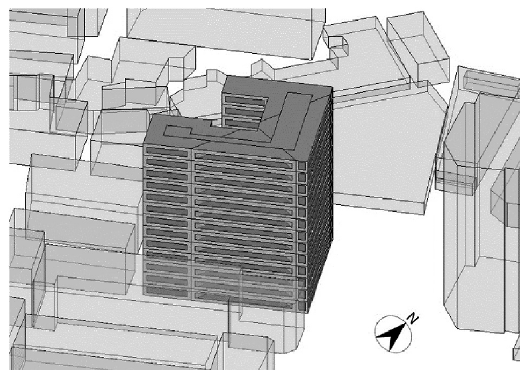
Figure 11. Conversion to an energy analysis model